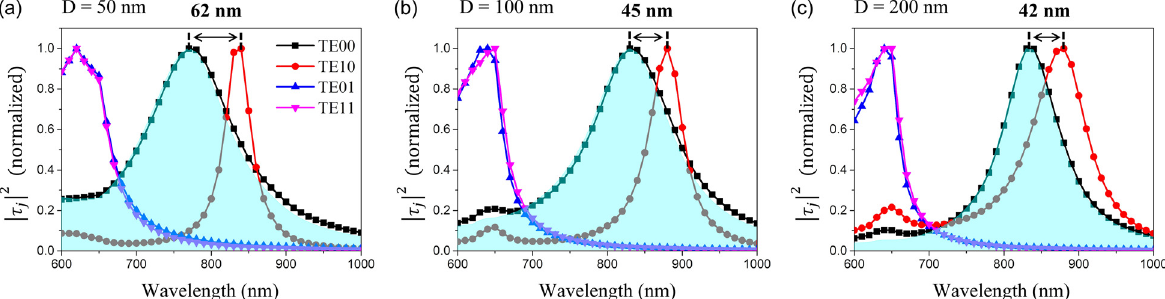
Figure 5: Energy spectra of double-slot nanoantenna depending on slot spacing. (a – c) Individual energy spectra for the slot spacingof double-slot nanoantennas: D = 50, 100, and 200 nm, respectively. The light-blue widow indicates normalized transmittance of double-slot nanoantennas with normally incident